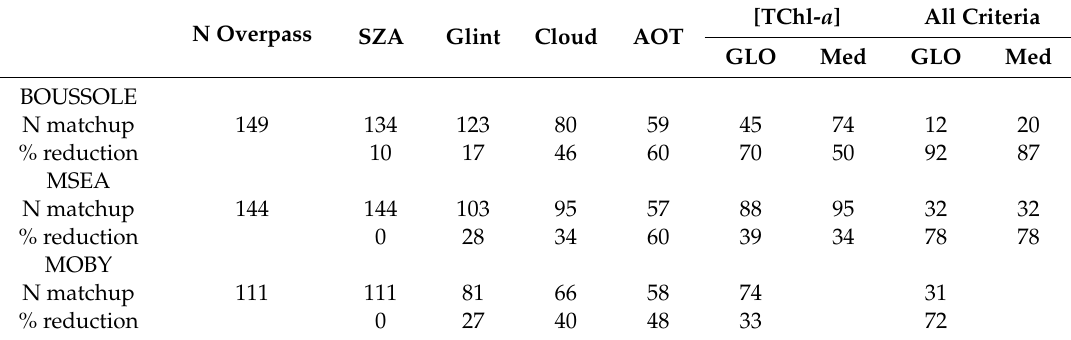
Table 1. Impact of each selection criterion when taken individually, and when combined together (last column) with the threshold values indicated in the text. The percentage reductions (rounded to integers) are calculated from the number of matchups after excluding the glint risk (so N = 123 for BOUSSOLE, 103 for MSEA and 81 for MOBY). GLO corresponds to the OC4ME algorithm and Med to the MedOC4ME algorithm. [TChl- a N Overpass SZA Glint Cloud AOT